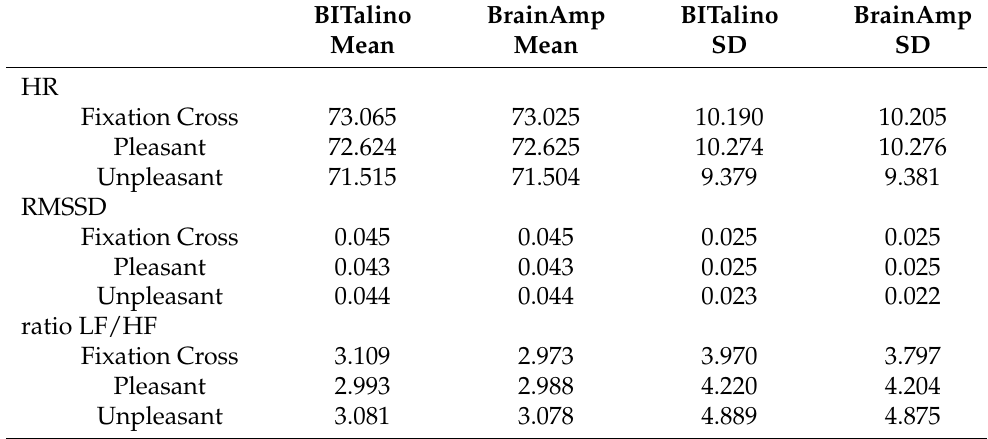
Table 3. Descriptive